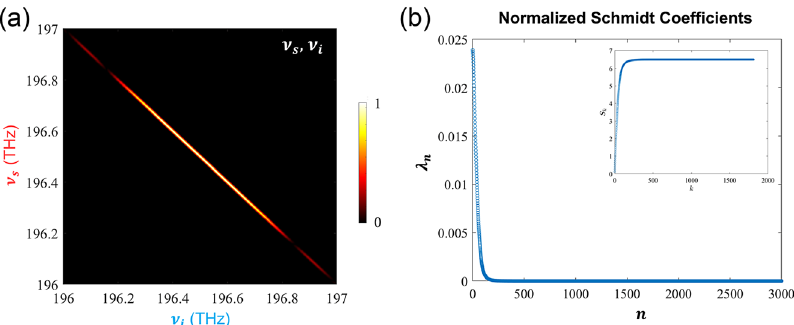
Figure 4: Quantum characteristics of